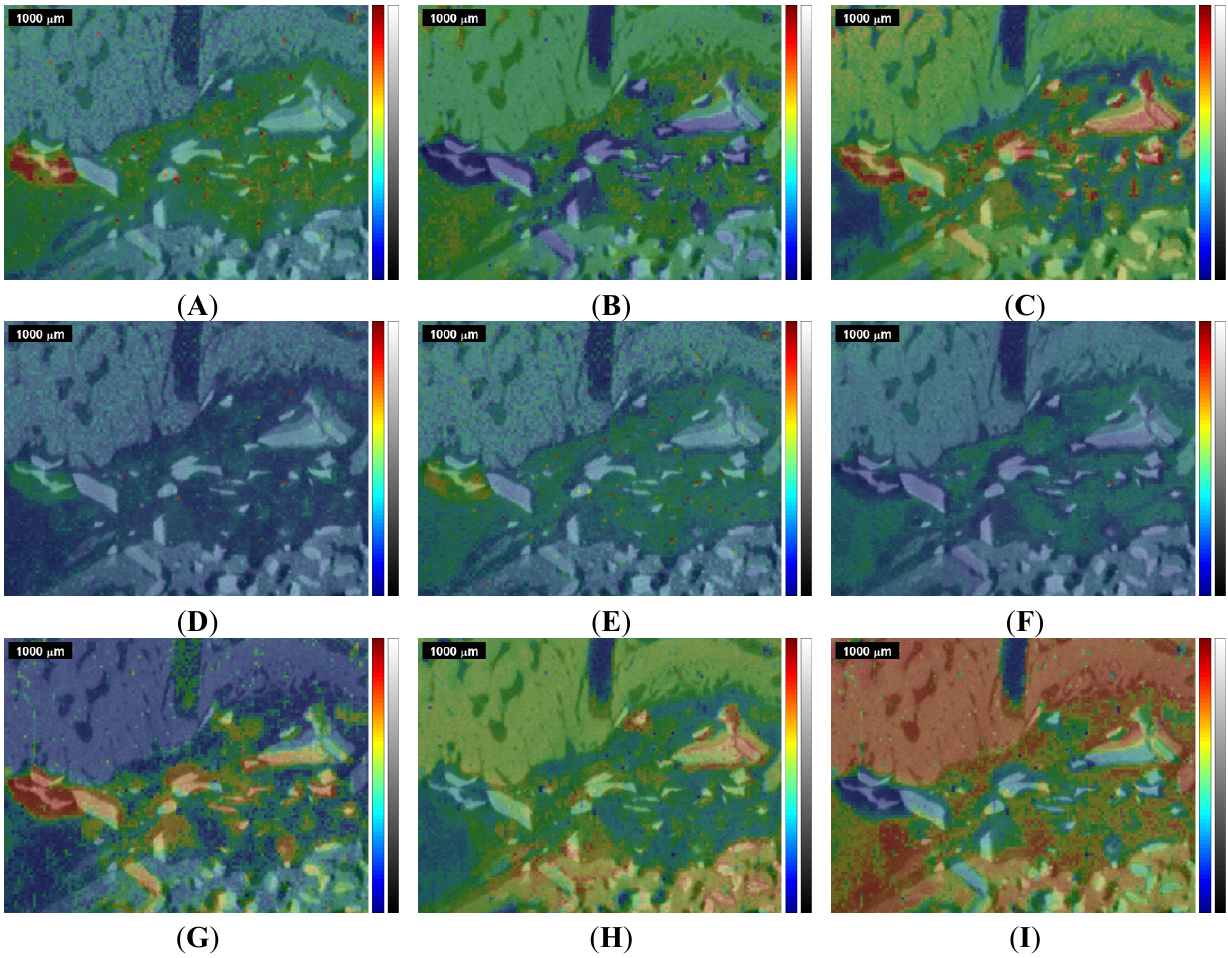
Figure 5. Overlap of the µ-CT image with the Raman images and correlation maps obtained within ROI 2 from the 2nd measurement of the sinus grafted bone sample (compare Figure 3 and supplementary information). Upper row: ( A ) Raman image centered at the CH bending peak at 1457 cm − 1 ; ( B ) natural pork fat Raman correlation map; ( C ) Raman image centered at the ν 1 PO 43 − peak at 961 cm − 1 . Mid row: Raman images centered at ( D ) the B-type carbonate substitution peak at 1075 cm − 1 ; ( E ) the amide I peak at 1677 cm − 1 ; ( F ) the CH stretching peak at 2937 cm − 1 . Lower row: correlation of the individual spectra of the Raman map with the ( G ) Bio-Oss ® Raman spectrum; ( H ) natural pork bone Raman spectrum; ( I ) tricalcium phosphate Raman